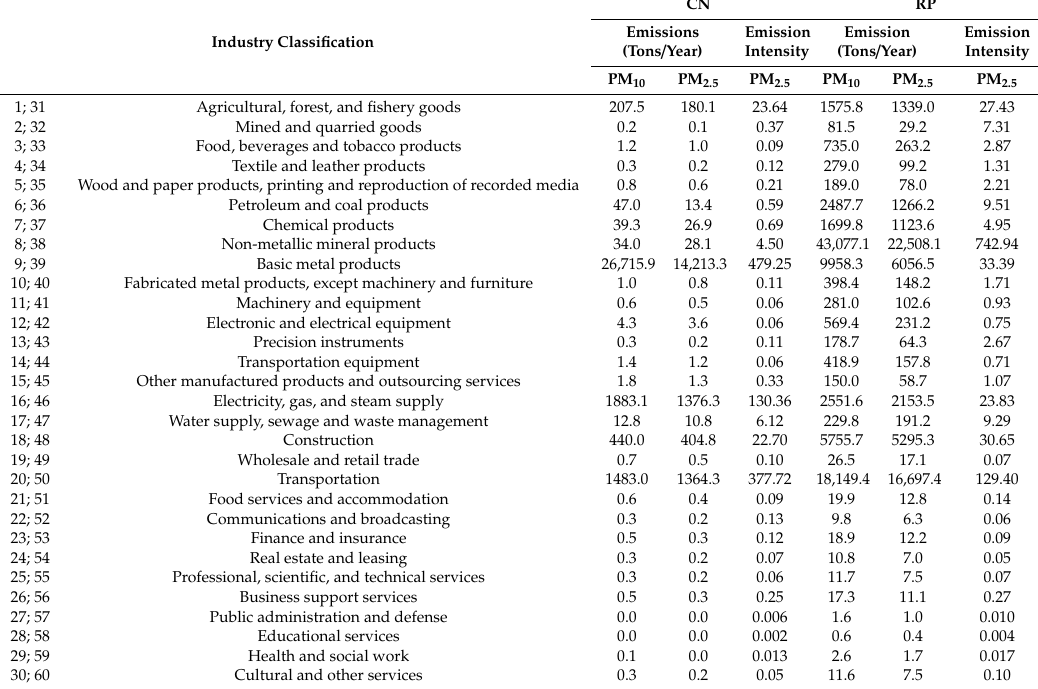
Table A2. PM emission and emission intensity by industries in 2013 (g / l000